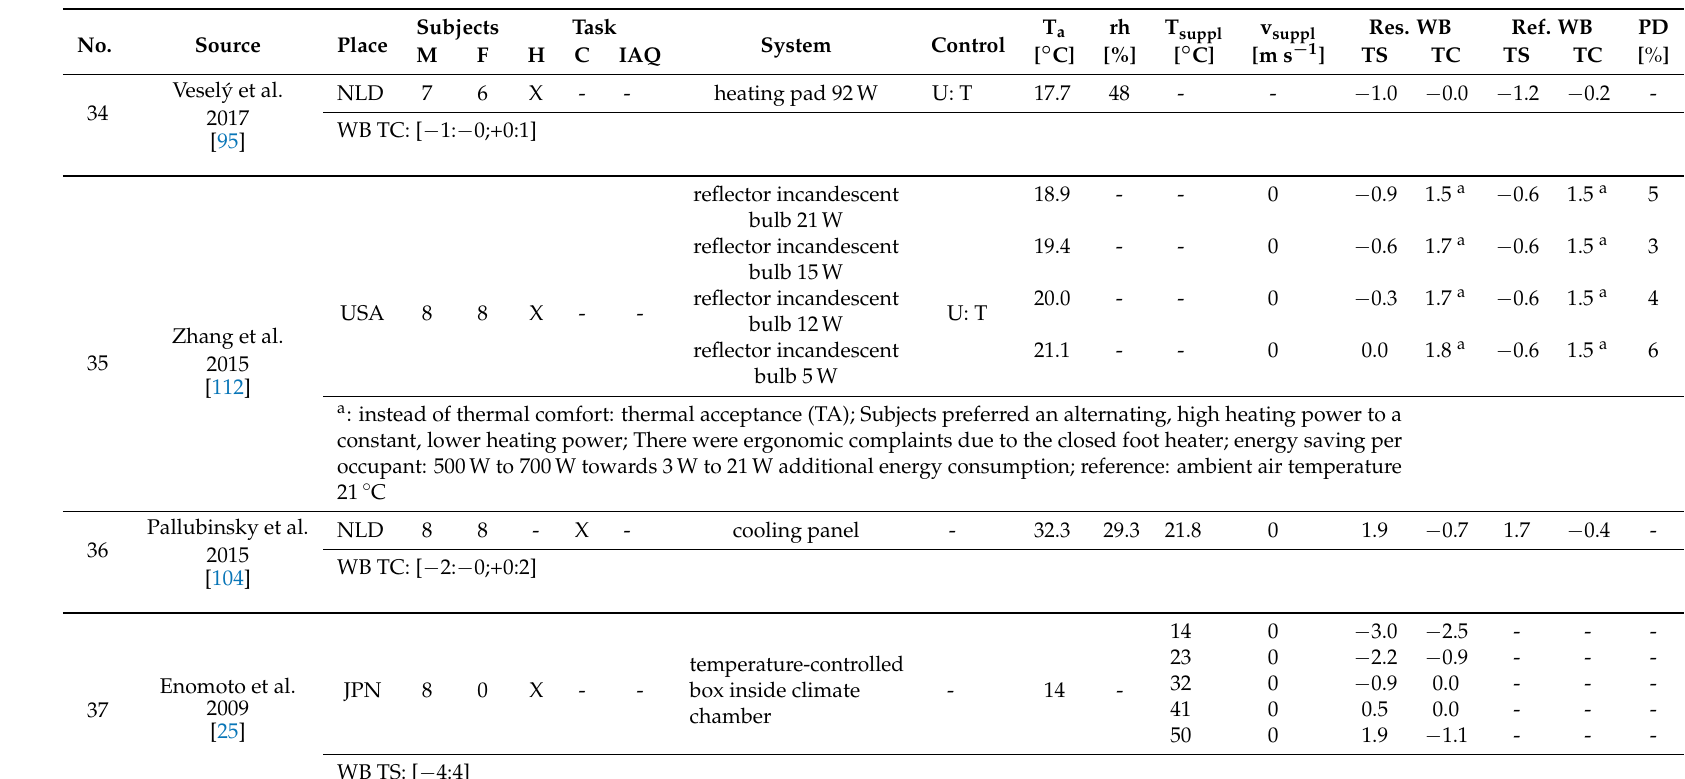
Table A4. Personal climatization systems concerning the lower human body